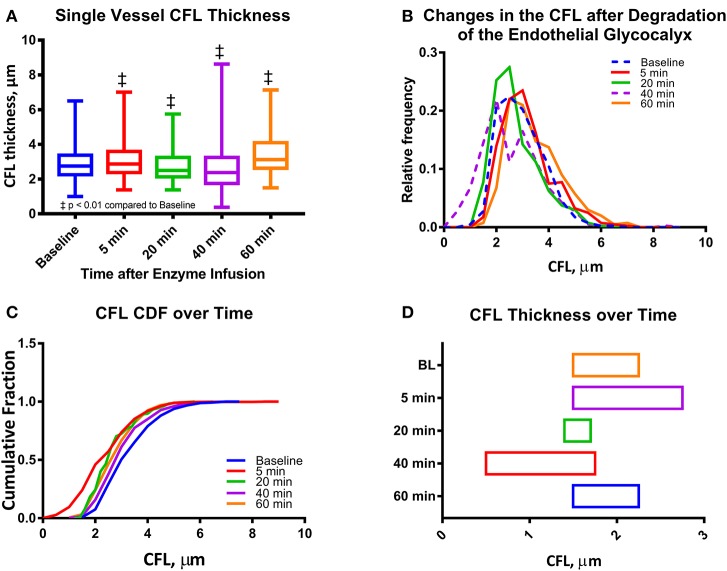
Single microvessel CFL thickness during enzymatic degradation of the EGL: (A) CFL thickness over time after enzyme infusion. The changes in the mean CFL were found to be statistically significant (‡P < 0.05) at all-time points. (B) Histograms of CFL thickness over time after enzyme infusion. (C) Cumulative distribution functions (CDF) of CFL thickness over time after enzyme infusion. (D) One tailed 99% confidence interval of CFL over time after infusion. The left hand bound was determined as the point on the CDF at which P < 0.01, and the right hand bound was determined as the inflection point of the CDF (see Supplemental Figure 1). (‡P < 0.05) compared to baseline.